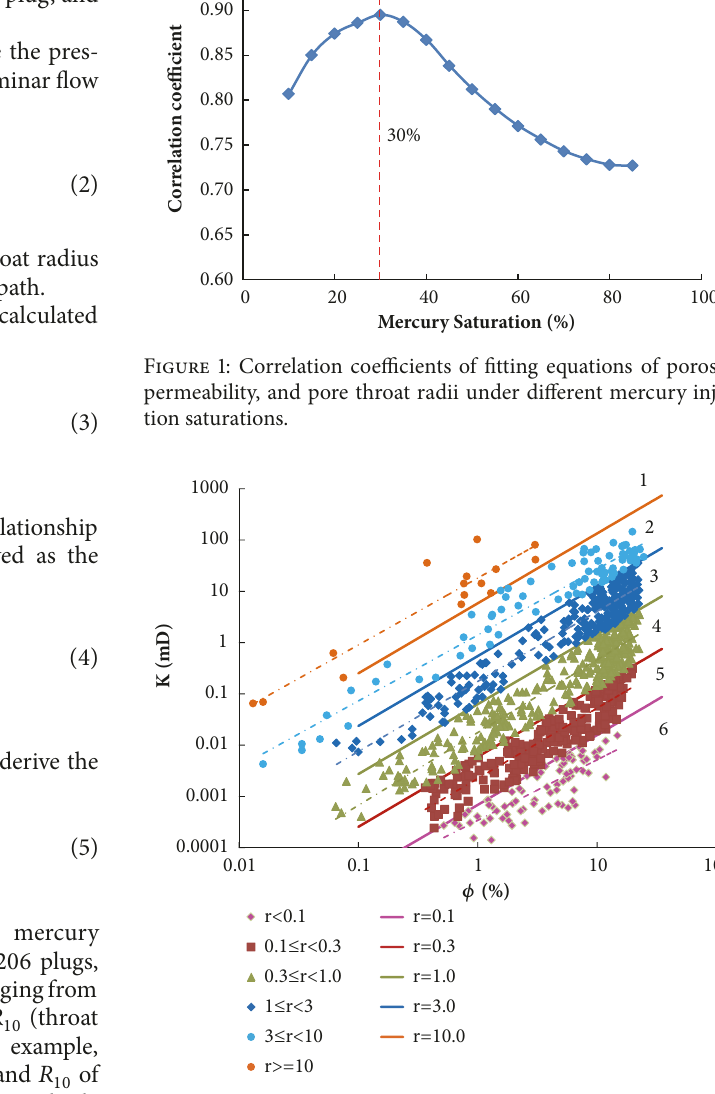
Figure 2: Rock type classification of K